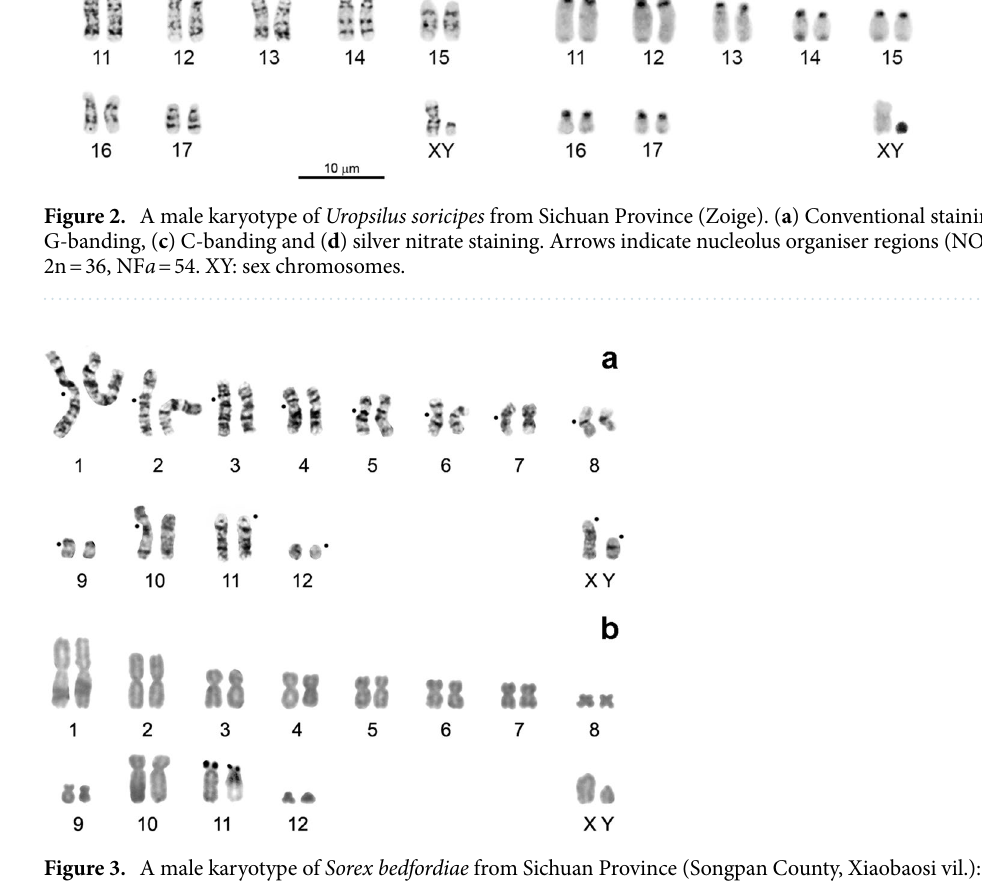
Figure 3. A male karyotype of Sorex bedfordiae from Sichuan Province (Songpan County, Xiaobaosi vil.): ( a ) G-banding, ( b ) silver nitrate staining. 2n = 26, NF a = 44. XY: sex chromosomes. Centromere positions are marked by black points.